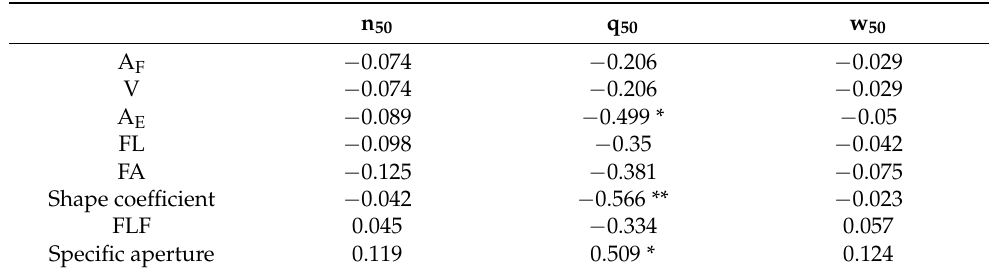
Table 6. The Spearman’s Rho test results show the correlations between building and airtightness parameters (n 50 , q 50, and w 50